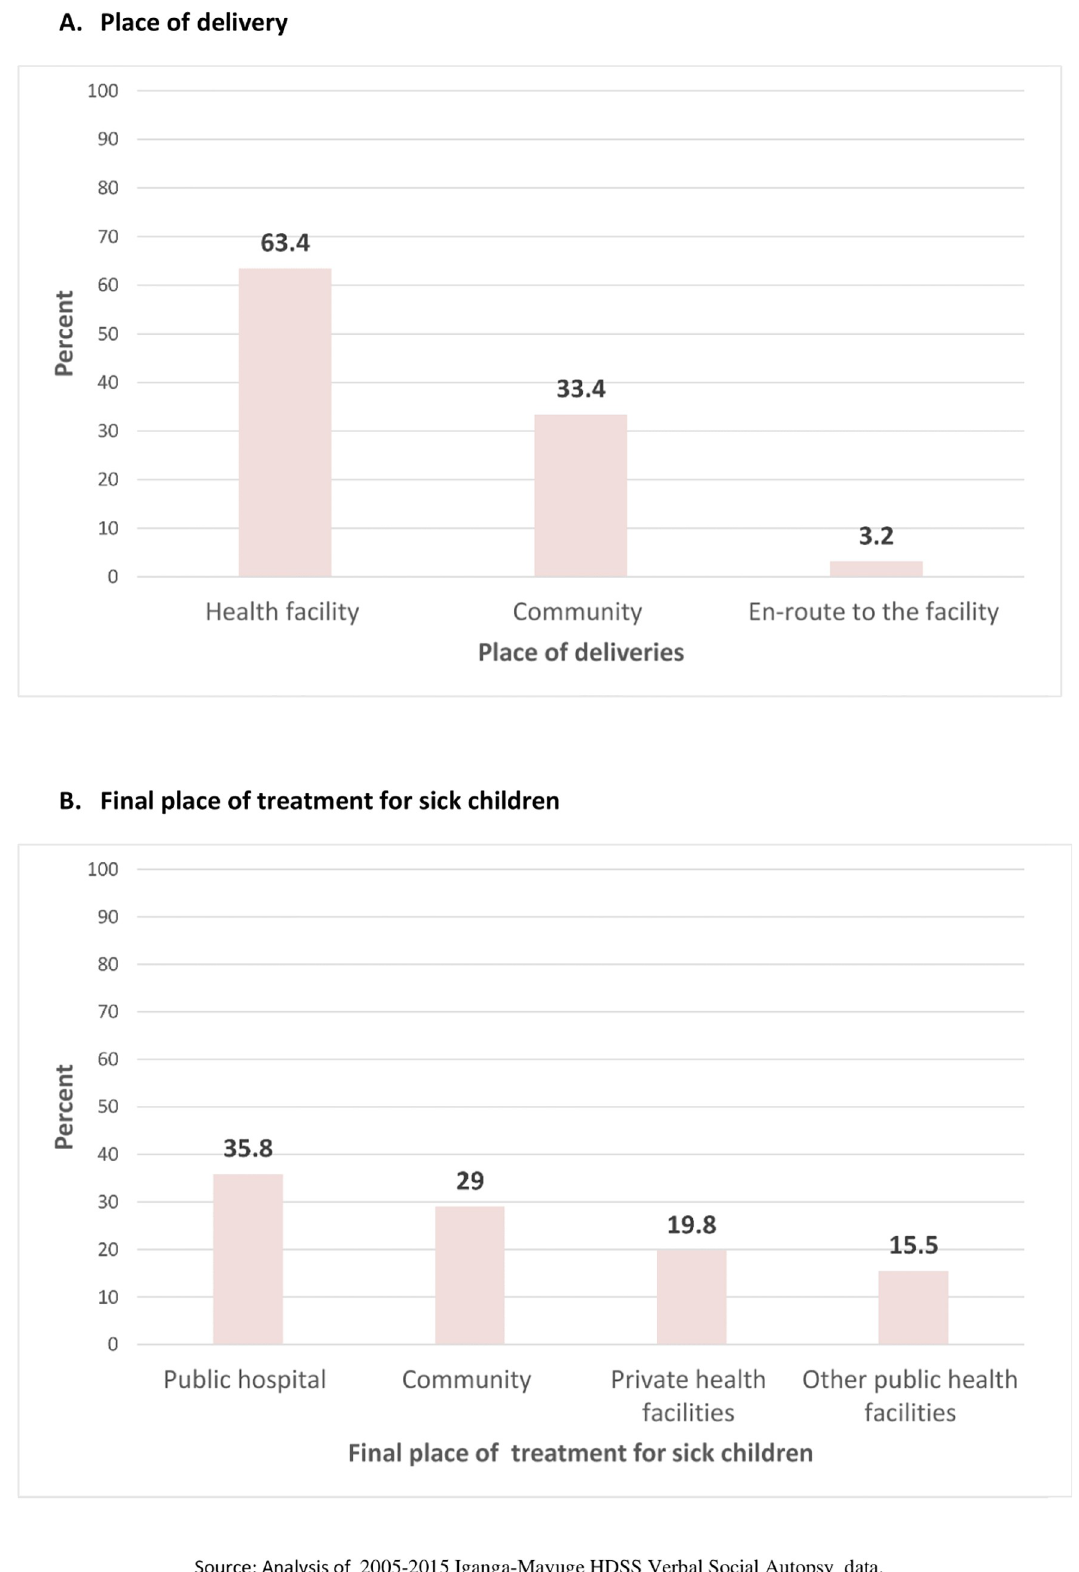
Fig 2. Places of birth and treatment for sick children. https://doi.org/10.1371/journal.pone.0234573.g002 PLOS ONE | https://doi.org/10.1371/journal.pone.0234573 June 11,